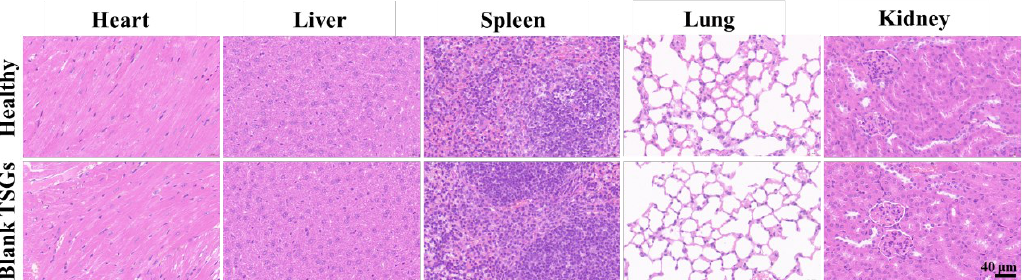
Figure 6. H.E staining of visceral organ in vivo. Scale bar = 40 μm. Healthy group: no operation; Blank TSGs group: continuous injection of blank TSGs for 7 d. No significant difference indicating safety in vivo of EDA TSGs.